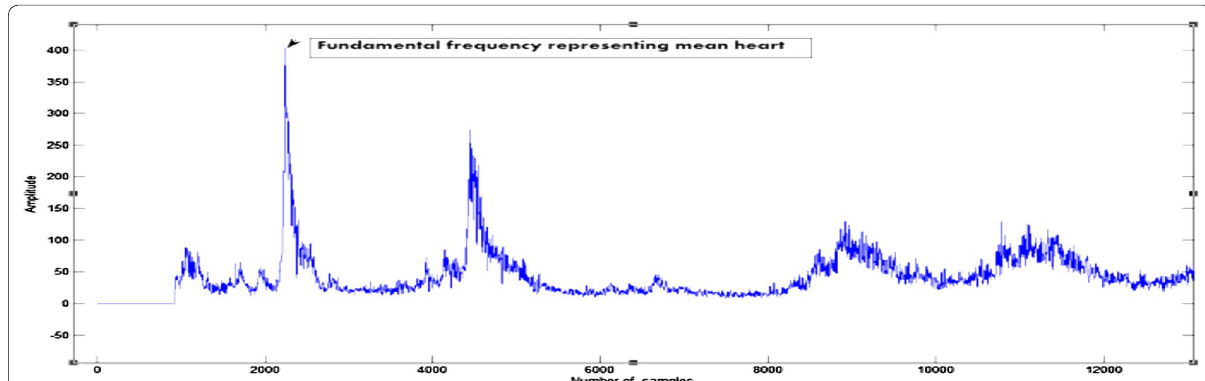
Fig. 12 Fundamental frequency representing mean heart rate